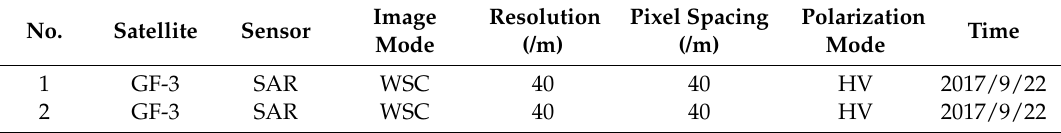
Table 2. GF-3 remote sensing image data (SAR = synthetic aperture